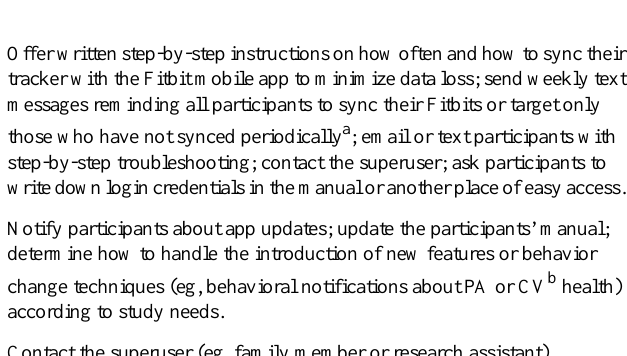
Table 3. Challenges and solutions or strategies for utilizing the Fitbit physical activity (PA) tracker in health interventions at the intervention delivery